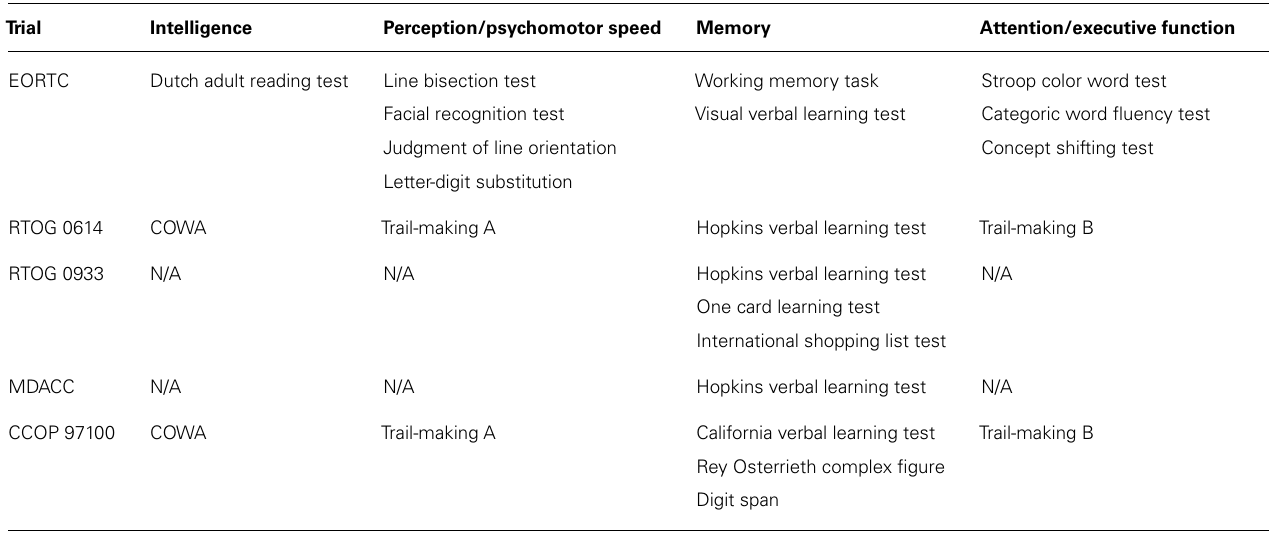
Table 1 | Neurocognitive batteries used in modern prospective clinical